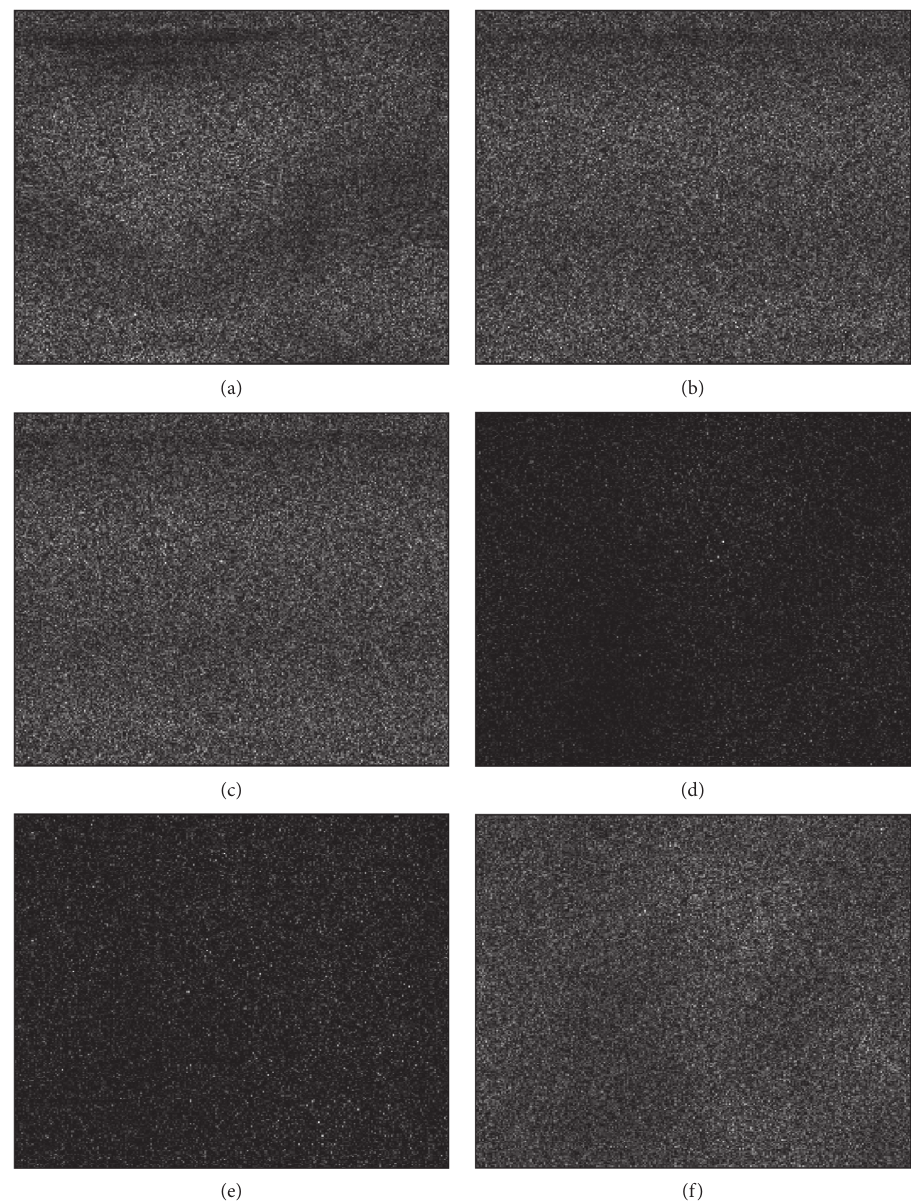
Figure 7: (a, b) Retrieved images of tree, baboon for wrong two LCTorders; (c, d) decrypted images using another two-wrong parameter; (e, f) wrong values of DPM and